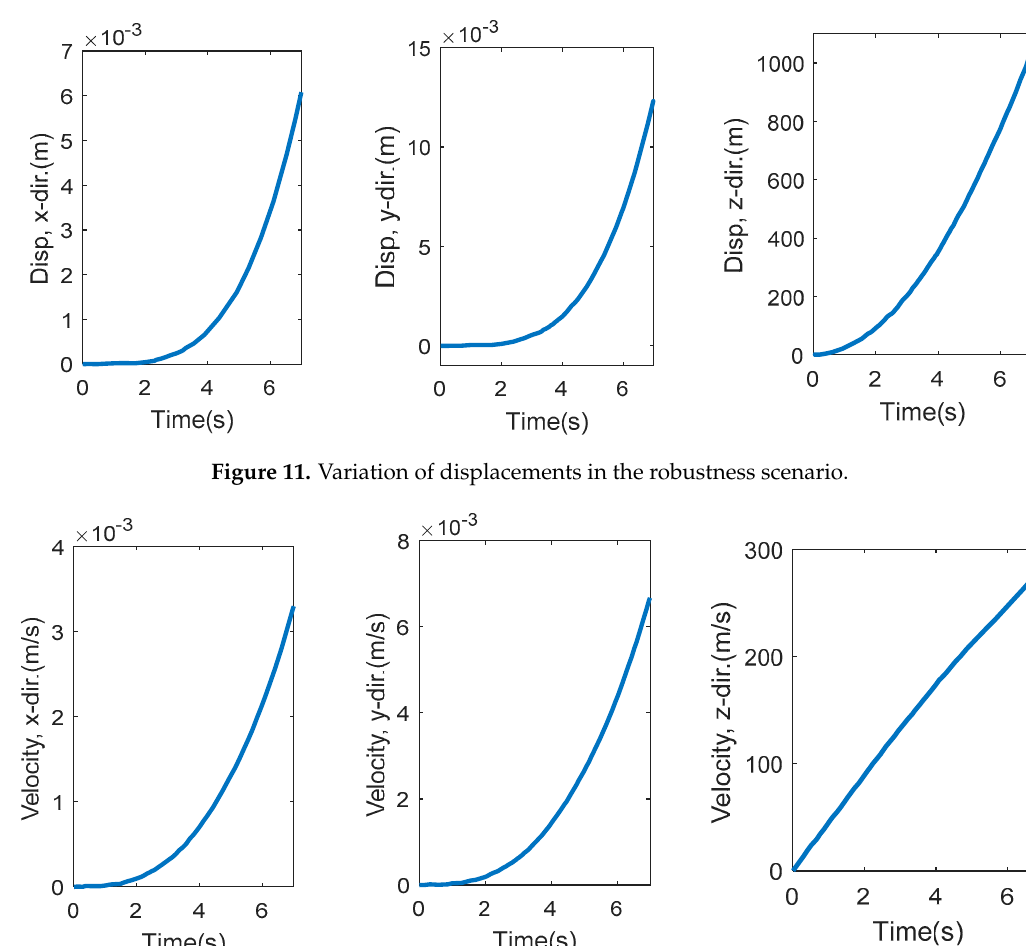
Figure 10. Prescribed variations of thrust in the robustness scenario.